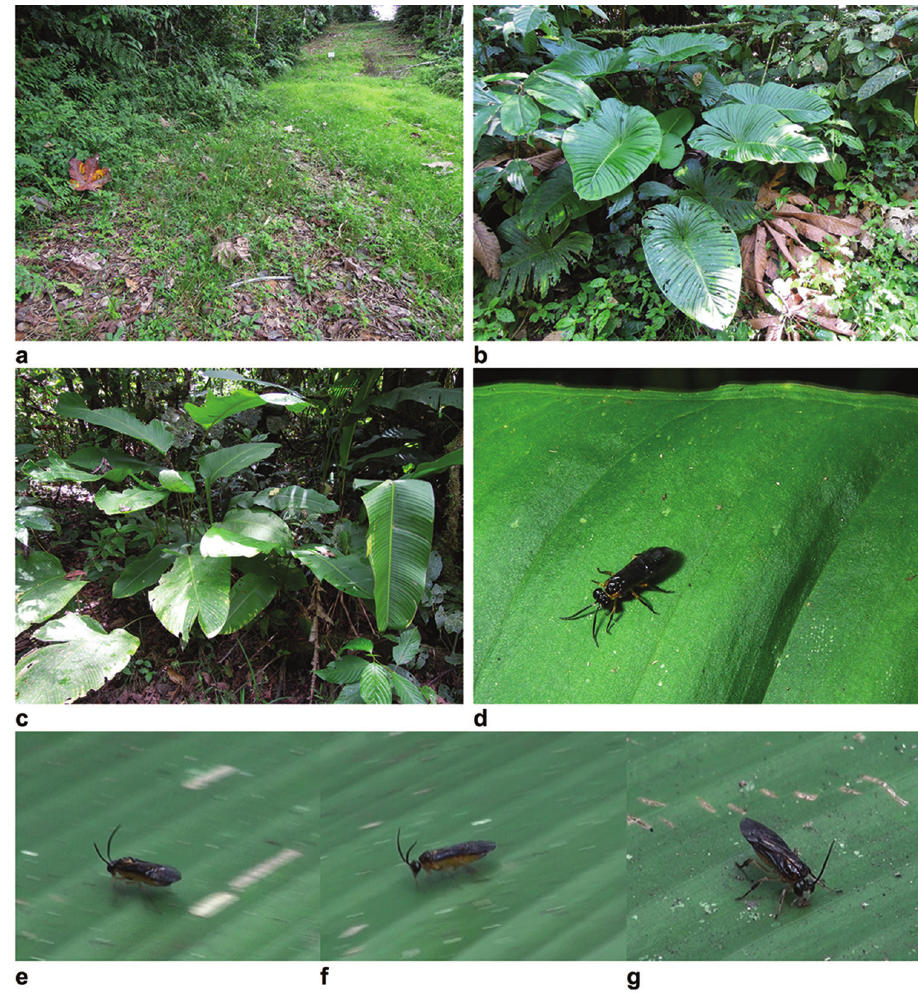
Figure 1. Pictures taken in the field, showing some biotopes and sawfly adults from northern Ecuador. Location a–g Yasuni National Park h Pacto i–m Hacienda San Vicente, Mindo. Leaves of b Anthurium sp. and c Heliconia sp., inspected by d Proselandria alvina and e–g probably Manaos mammeatus ,